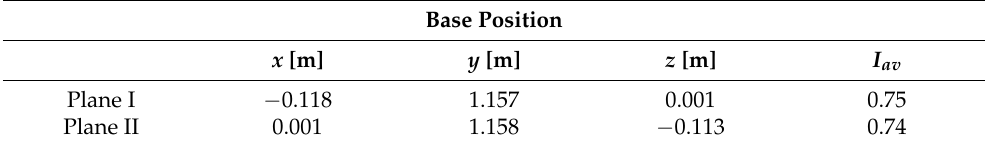
Table 6. Output of the local